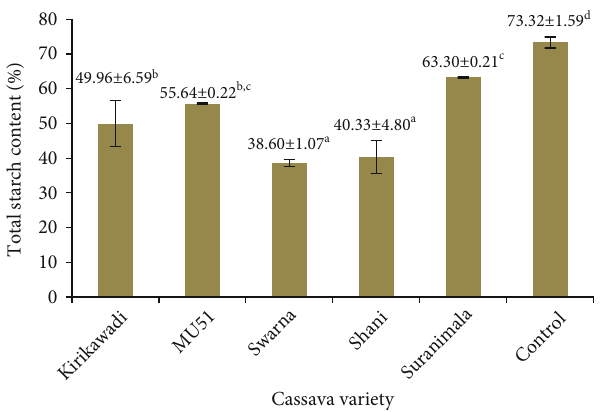
Figure 4: Starch contents of cassava fl ours from fi ve Sri Lankan cassava varieties. Values are expressed as mean ± standard deviation of three independent determinations. Di ff erent superscripts represent signi fi cantly di ff erent samples ( p < 0 : 05 ). Commercial wheat fl our was used as the